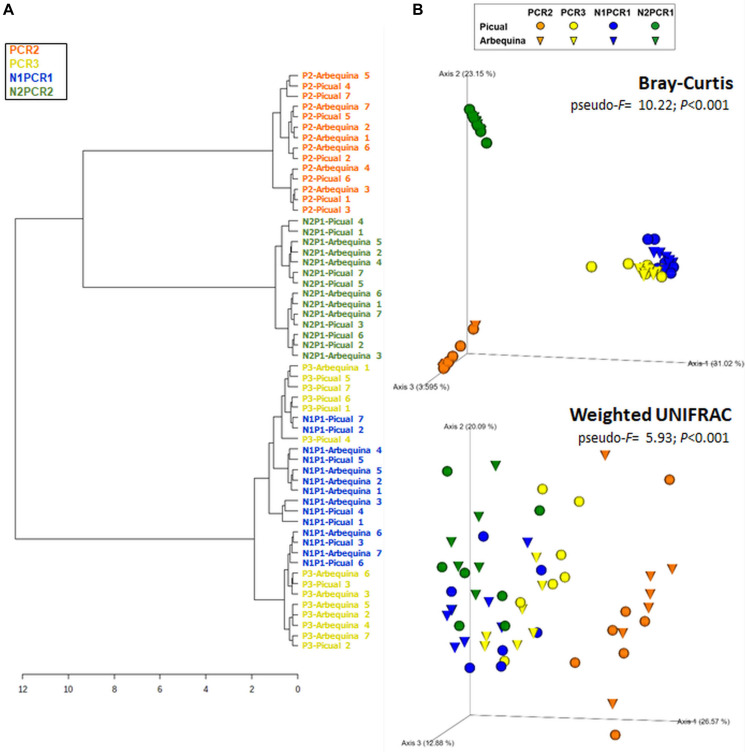
Hierarchical clustering dendrogram analysis using Ward method and Bray–Curtis distance (A) And principal coordinate analysis (PCoA) of weighted UniFrac and Bray–Curtis distances (B) Of xylem bacterial communities from “Picual” and “Arbequina” olive cultivars obtained by using different PCR primer pairs. PERMANOVA (999 permutations; P < 0.05) was performed to test significant differences according to PCR primers used and olive genotypes.